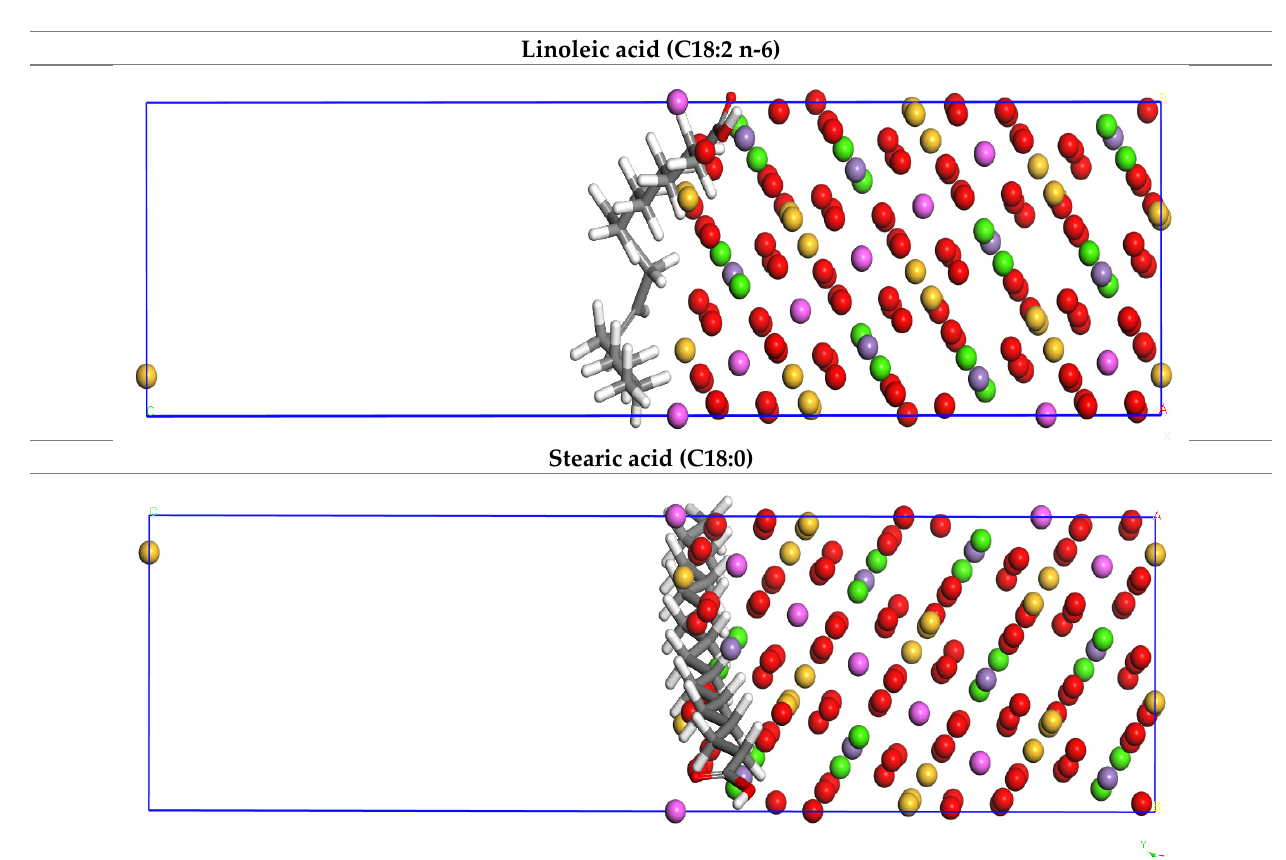
Figure 11. Side view of molecular simulations for the most favorable modes of adsorption for the inhibitors on Fe (1 0 0) surface. Table 8. The calculated descriptors (kcal/mol) of AO and HERA on Fe (1 0